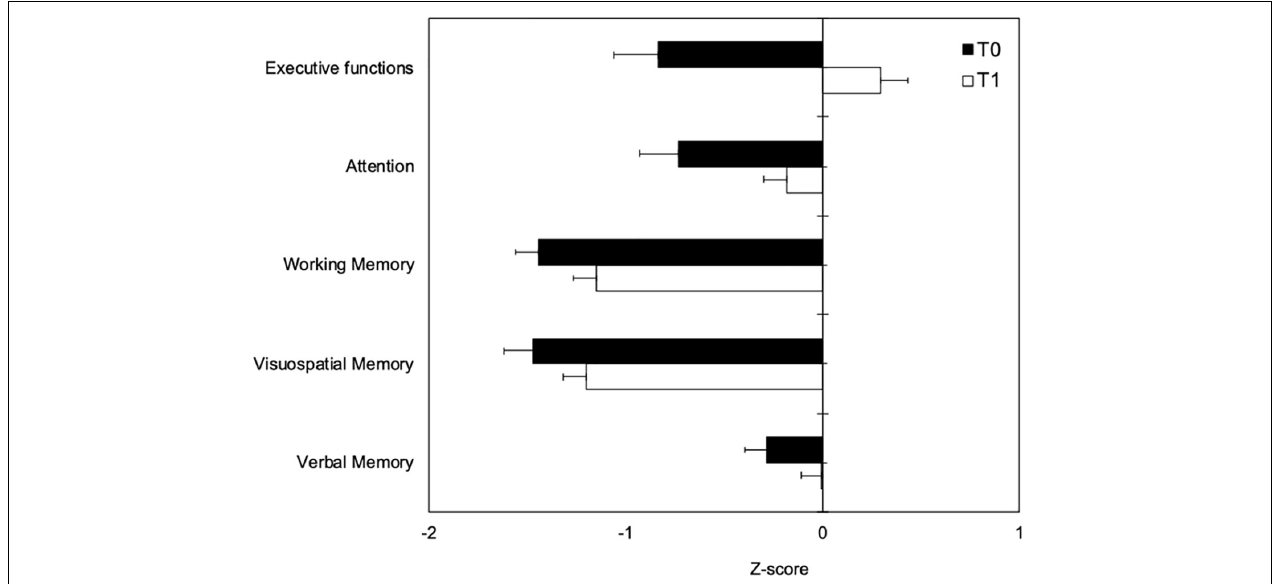
FIGURE 2 | Neuropsychological measures at T0 (black boxes) and T1 (white boxes) represented as Z-scores. Negative values indicating worse performance and positive values indicating better performance than the average value of the normal